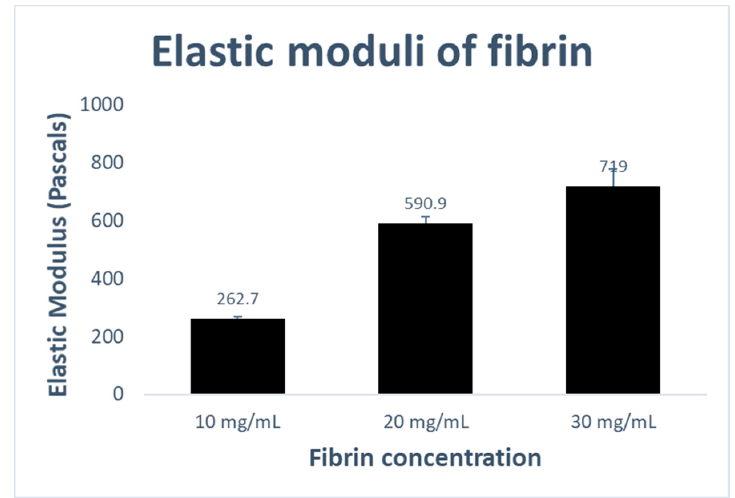
Table 1. Indentation parameters and elastic moduli values obtained for fibrin samples. Figure 2. Elastic moduli values obtained from modified Hertz model for thin films. Data is presented as the average and standard deviation of three sample replicates. as the average and standard deviation of three sample